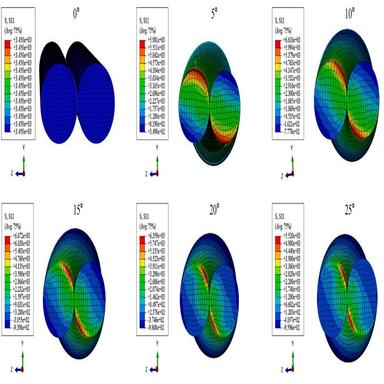
Stress distribution of carbon fiber tows with different twist angles for elliptical cross-section models.